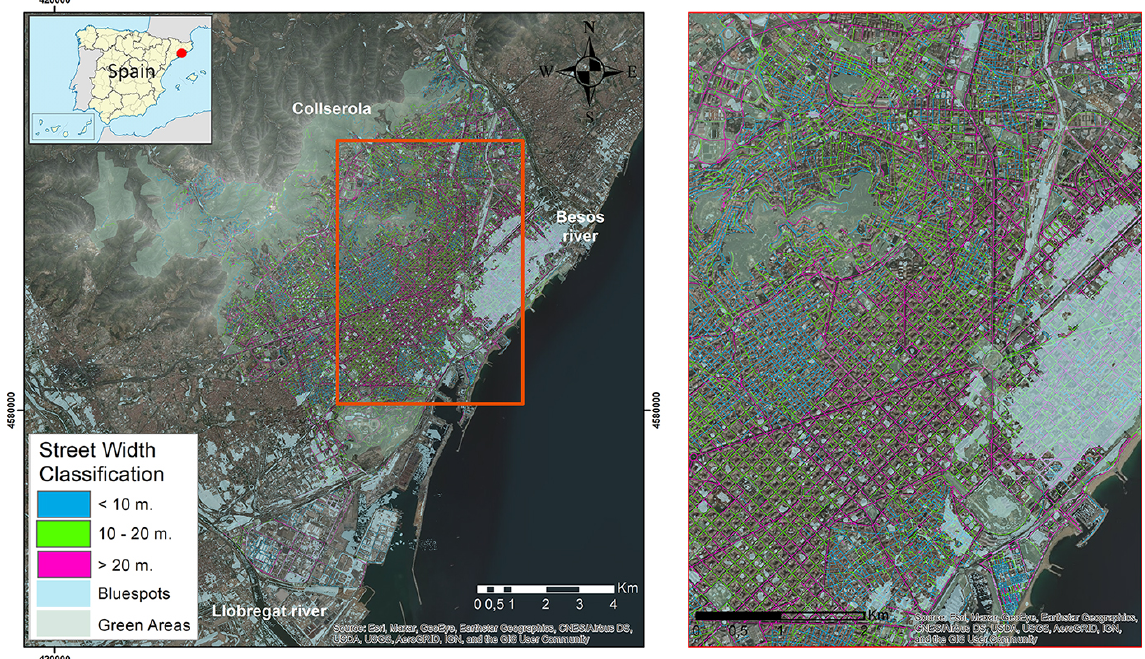
Figure 6. Additional information included in the DRASTIC method to evaluate the risk of infiltration of surface pollutants into the aquifers of the city. Streets width classification as 3 ranges: < 10 (greenblue); 10–20 (yellowgreen); > 20m (redmagenta) was used as indirect indicator of traffic. Bluespots (light blue polygons) shows potential areas of puddles during high precipitation events (Balstrøm, 2020). Source for basemap: © ArcGIS